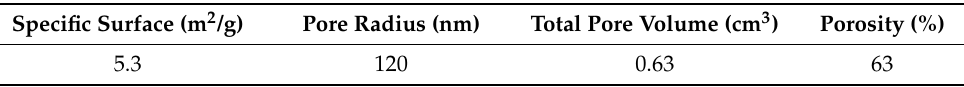
Table 2. The specific surface area, total pore volume, and the porosity for the produced sponge. Specific Surface (m 2